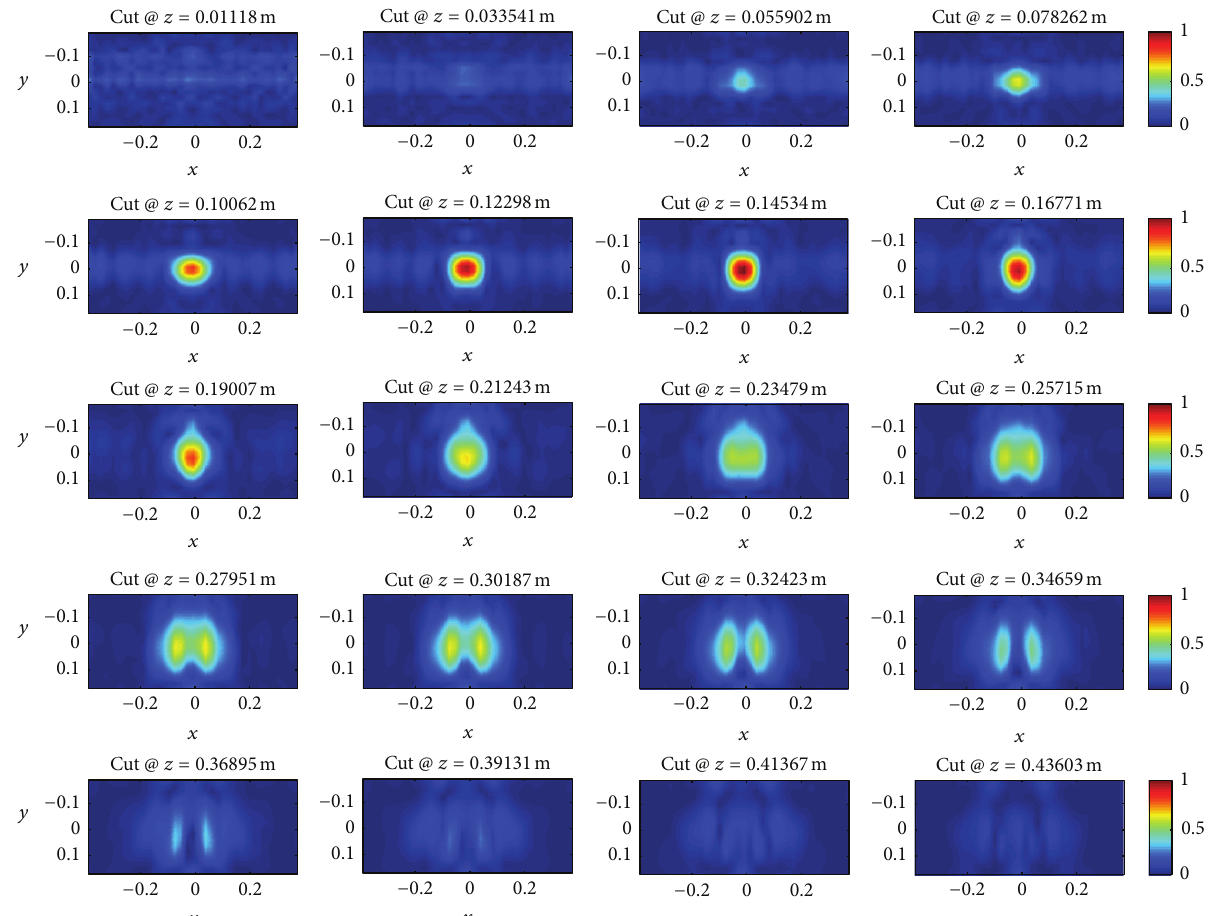
Figure 6: Depth slices of the contrast function reconstructed by processing the data set referred to a buried basalt cube as in Figure 2.